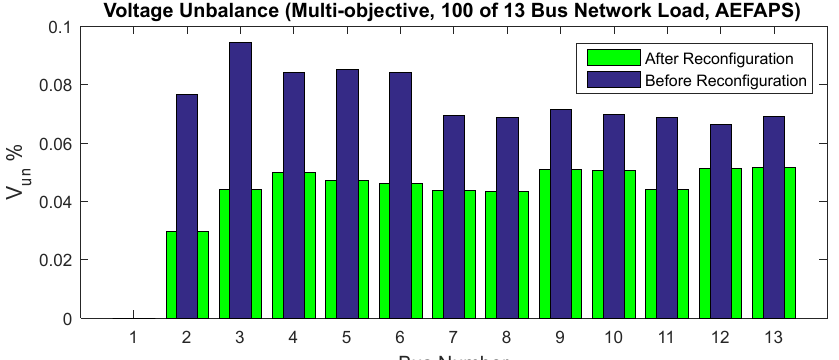
Figure 19. Voltage unbalances before and after many-criteria reconfiguration of an unbalanced 13-bus network using AEFAPS.